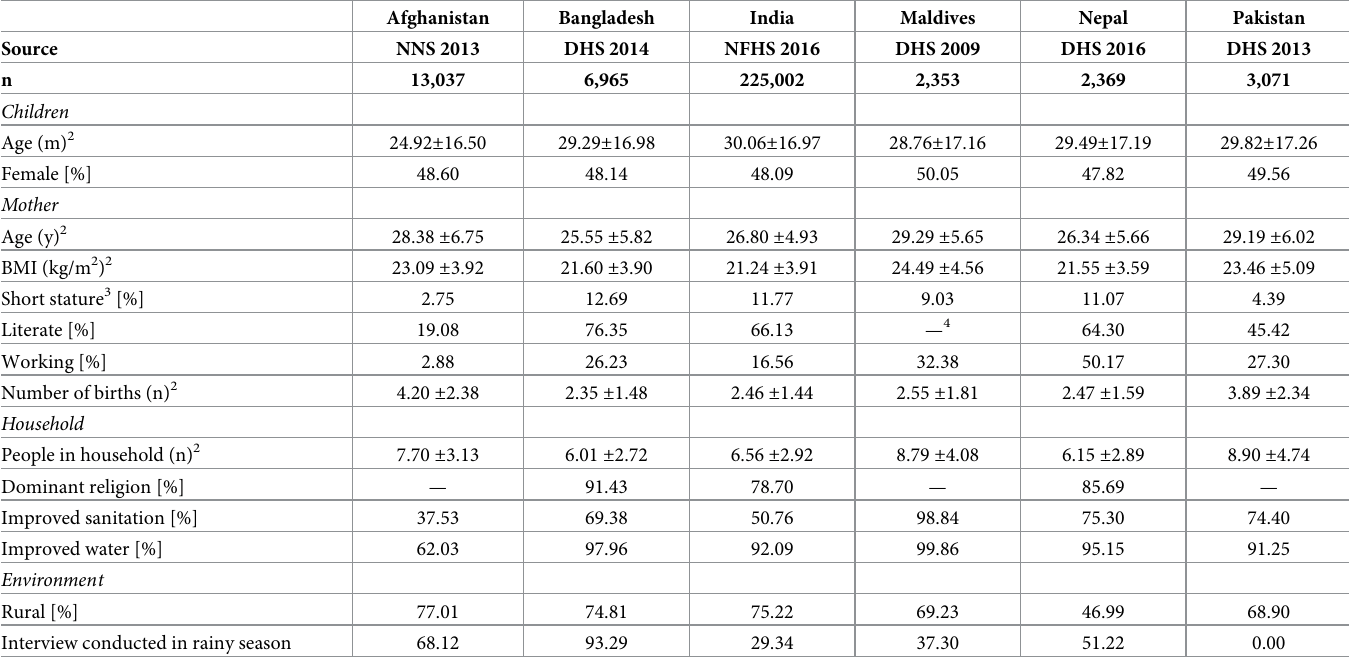
Table 1. Characteristics of the study populations 1